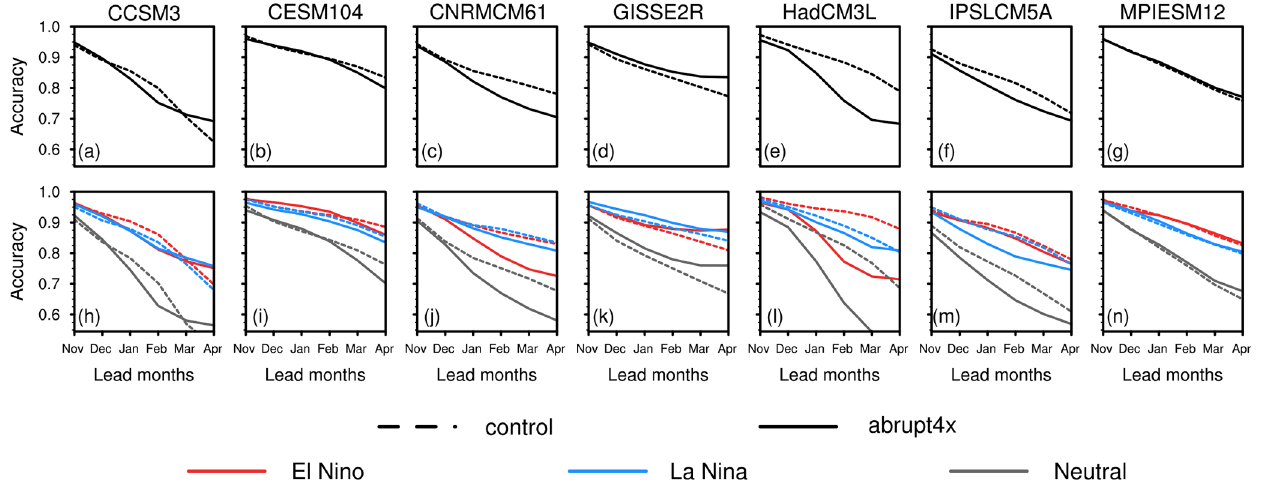
Figure 5. (a–g) Accuracy of persistence predictions of the mean ENSO state in the control and abrupt4xCO 2 . (h–n) Accuracy of persistence predictions of the El Niño, La Niña and neutral state in the control and abrupt4xCO 2